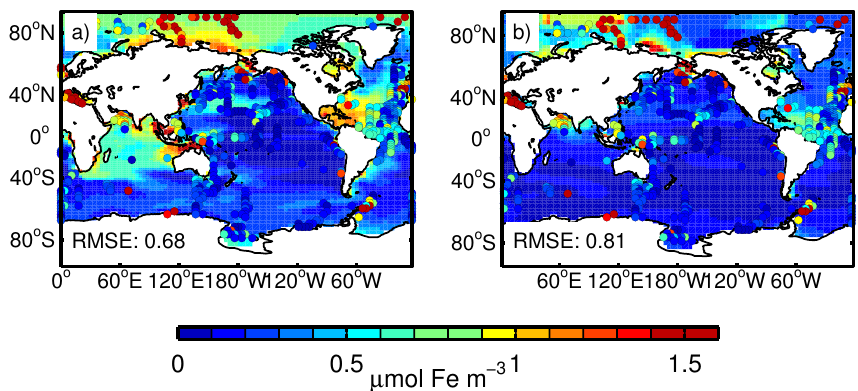
Figure 4. Annual mean surface iron concentrations (a) as simulated with the new model and (b) from the iron concentration mask used in the previous model version from Galbraith et al. (2010). Observations compiled by Tagliabue et al. (2012) are averaged over the first 50m and plotted as colored circles on top.